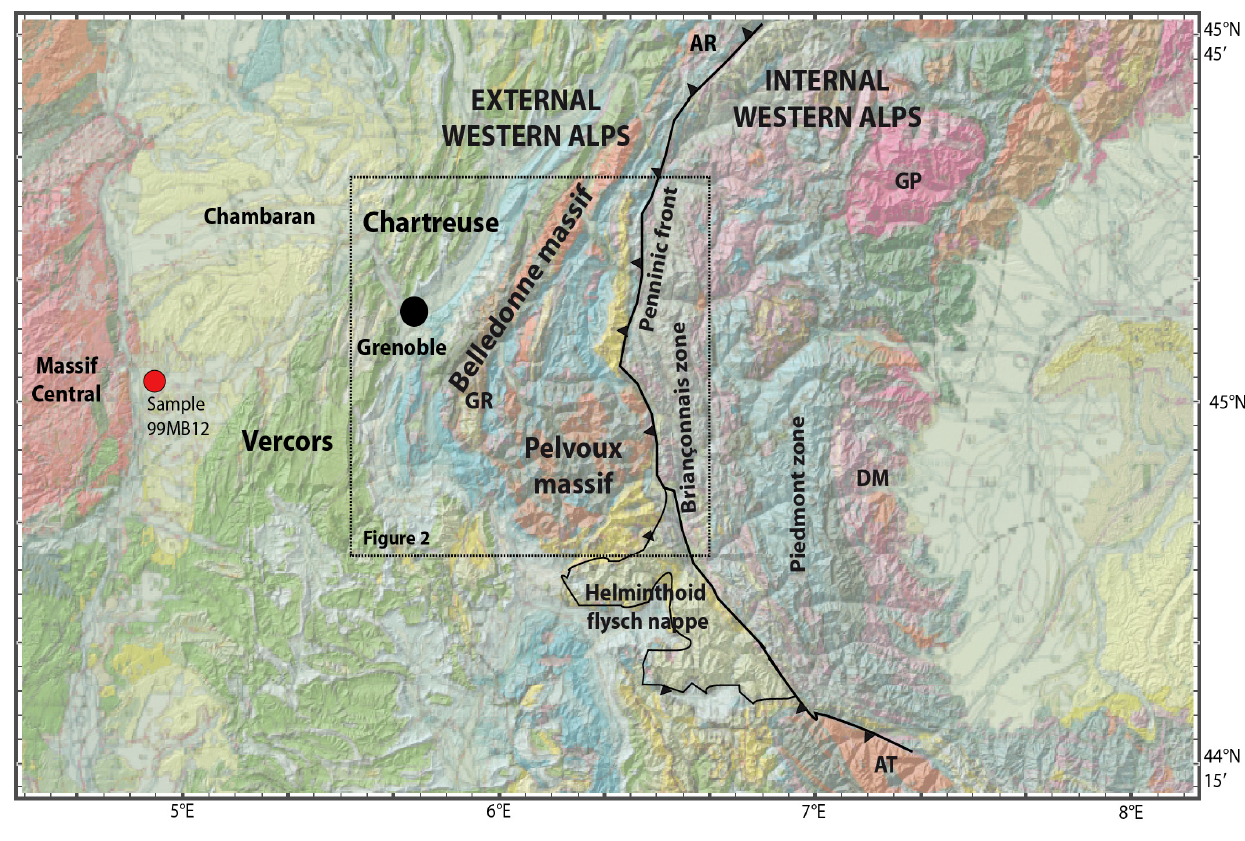
Figure 1. Overview geologic map of the Western Alps. AT = Argentera massif, AR = Aguilles Rouges massif, DM = Dora Maira massif, GP = Gran Paradiso massif, GR = Grandes Rousses. The map was created with GeoMapApp version 3.3.6 [14] using the BRGM geological Map of France 1:1,000,000